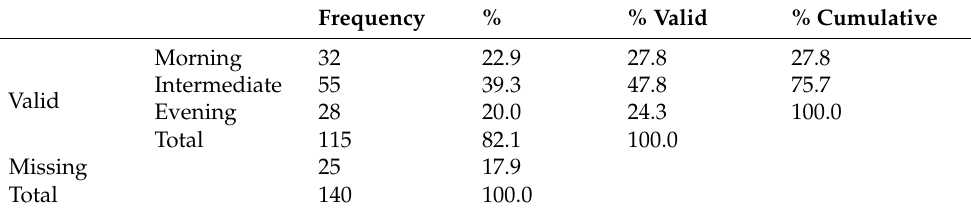
Table 2. Sample characterisation according to